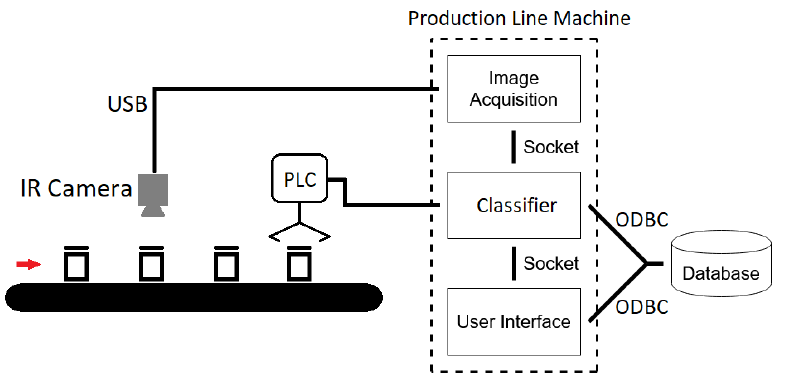
Figure 2. System